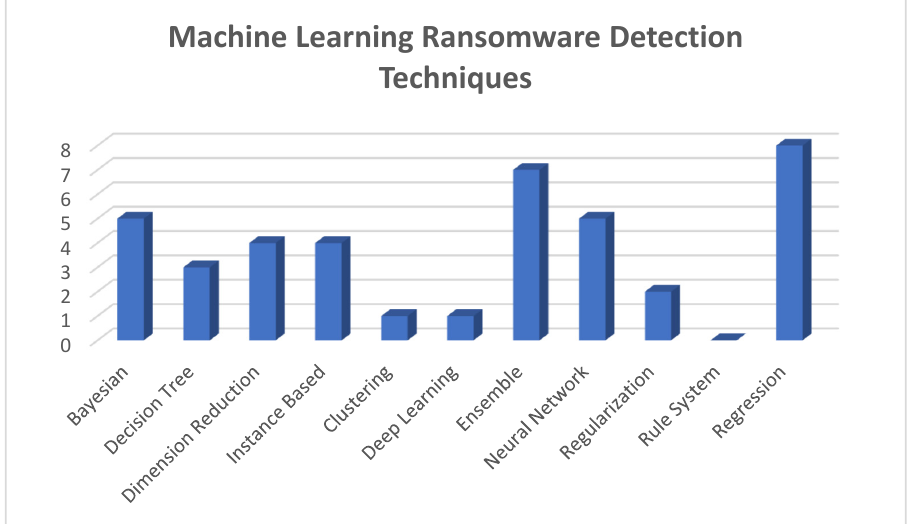
Figure 11. Machine Learning techniques used in ransomware detection.